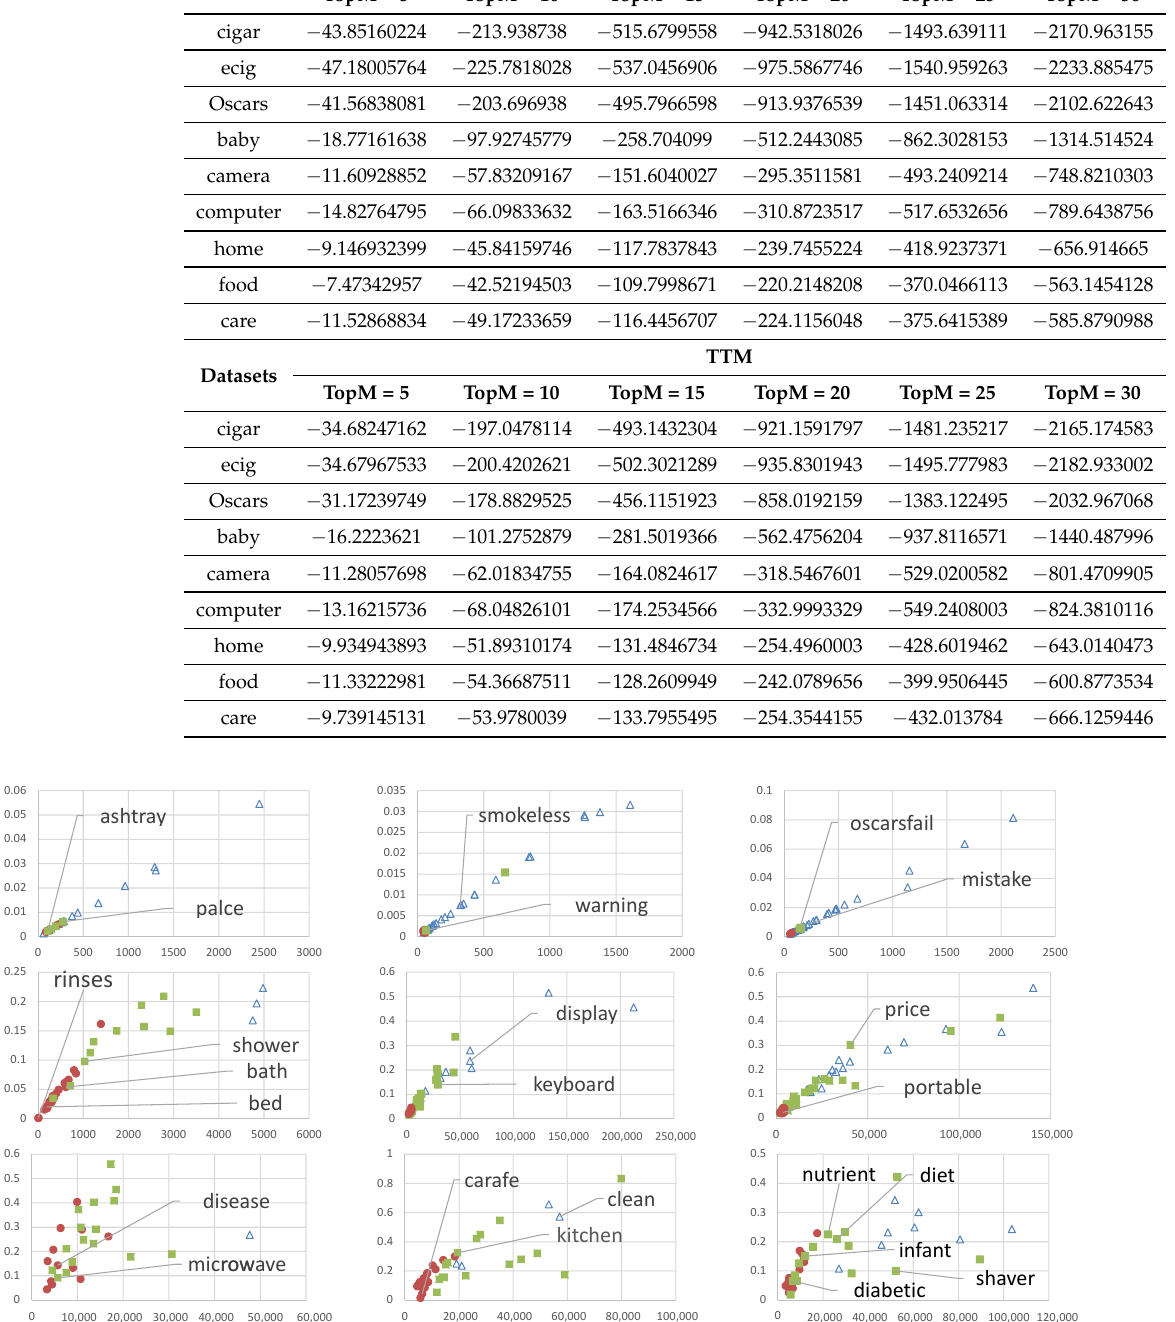
Figure 4. Effect of various targets on topic coherence. The x -axis shows the word frequency of targets, and the y-axis represents the percentage of documents containing a